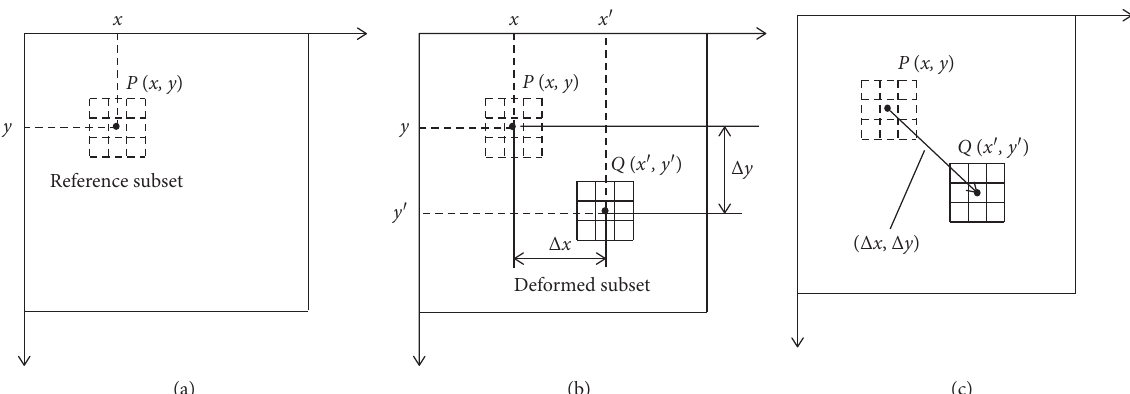
Figure 1: OMA flowchart.